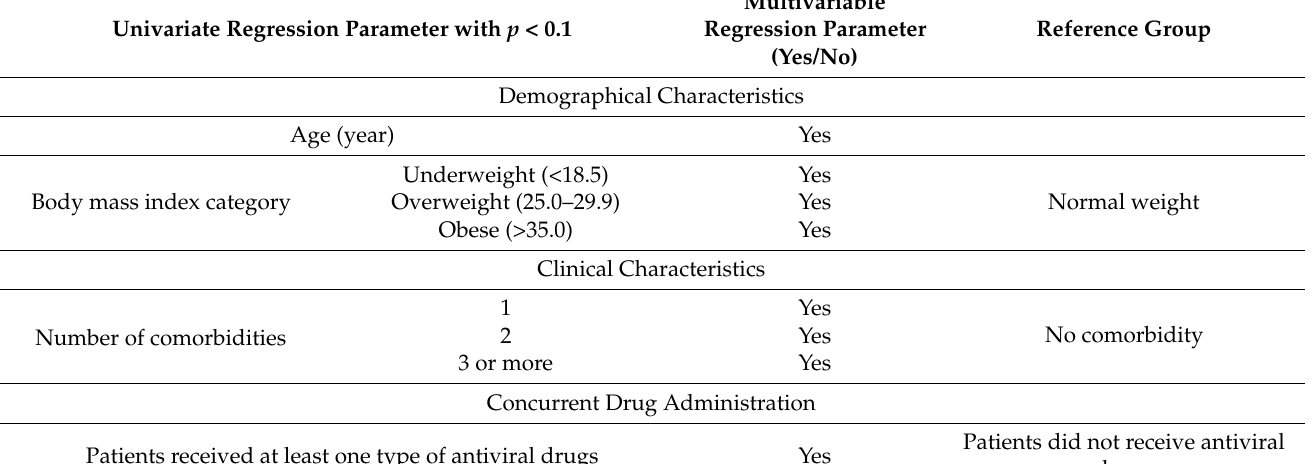
Table 1. Univariate and multivariable logistic parameters (demographical, clinical characteristics, concurrent drug administration, time- and tocilizumab-related parameters, and lab results) for mortality in COVID-19 patients on